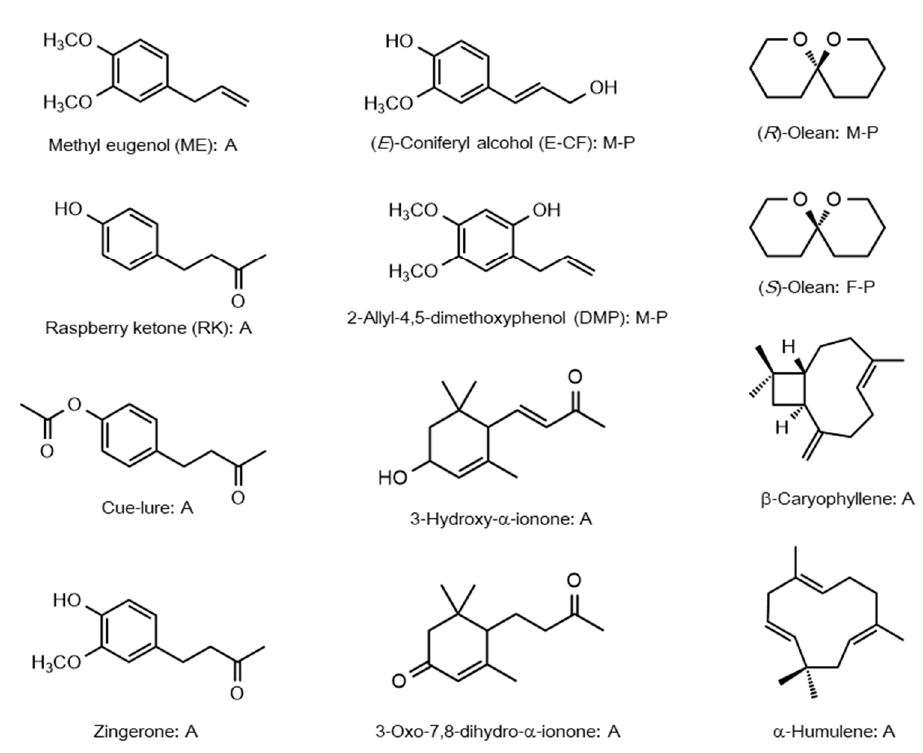
Figure 1. Structures of representative attractants and sex pheromones in Dacini fruit flies. A: Attractant; M-P: Male sex pheromone; F-P: Female sex pheromone.